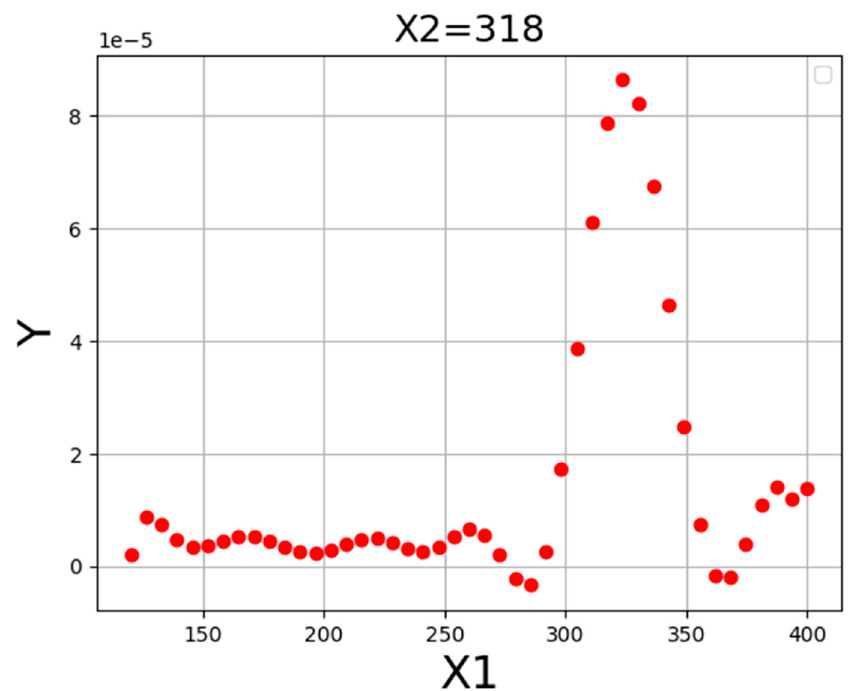
Figure 5. Tendency of X1.